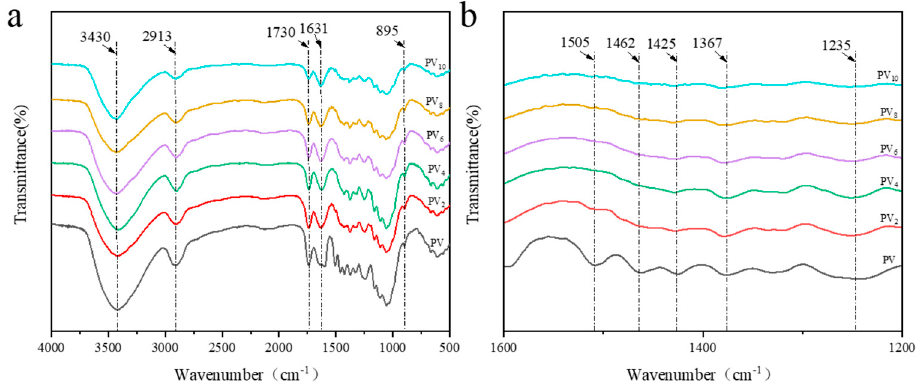
Figure 3. FTIR spectra of PV and PVs with different delignification time. ( a ) FTIR spectrum of the 4000–500 band, ( b ) FTIR spectrum of the 1600–1200 band.